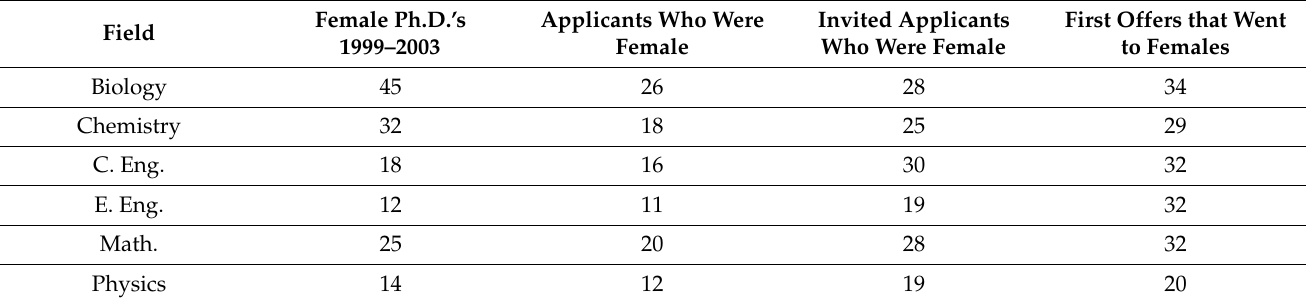
Table 1. Percentage of Ph.D.’s transitioning toward faculty STEM positions who were